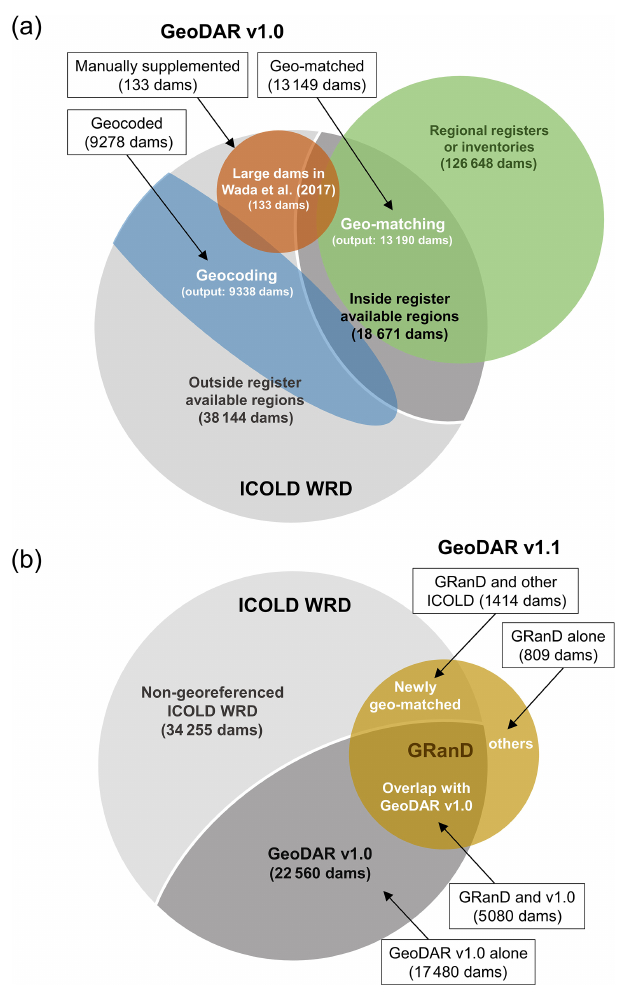
Figure 2. Venn diagrams illustrating the logical relations among georeferencing data sources and methods for GeoDAR. (a) Geo- DAR v1.0 and (b) GeoDAR v1.1 (dams only). Boxes indicate the final subsets in each GeoDAR version, and the arrows point to the georeferencing sources or methods. Topology of the shapes illus- trates logical relations among the data and methods (shape sizes were not drawn to scale of the data